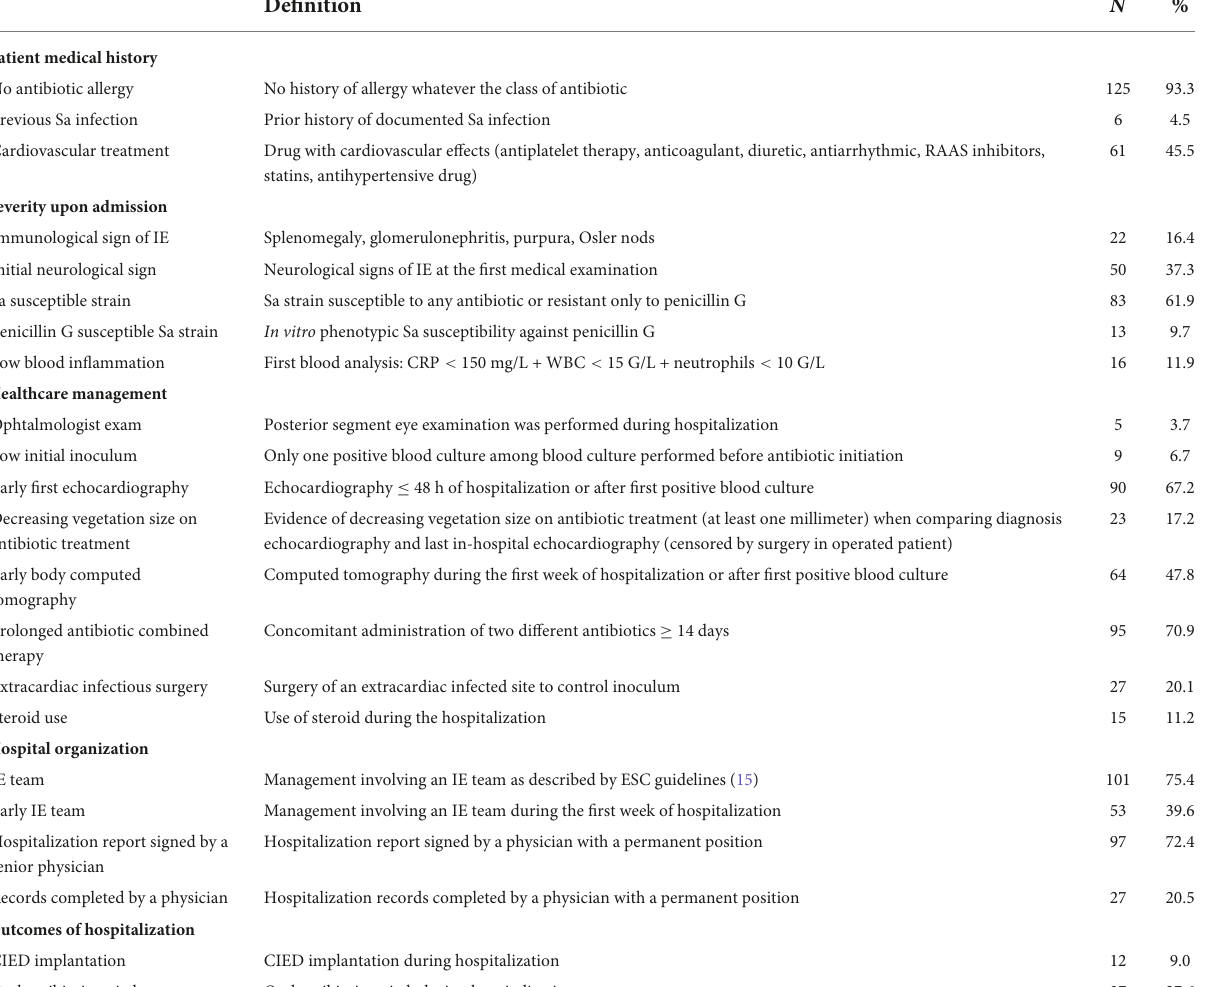
TABLE 2 Description of candidate prognostic factors that could be associated with survival in the 134 Staphylococcus aureus infective endocarditis patients.